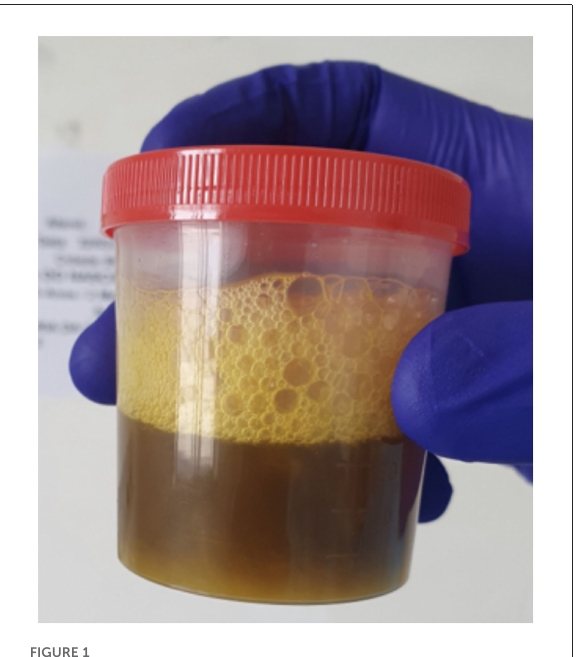
FIGURE1 Sample of yellowish